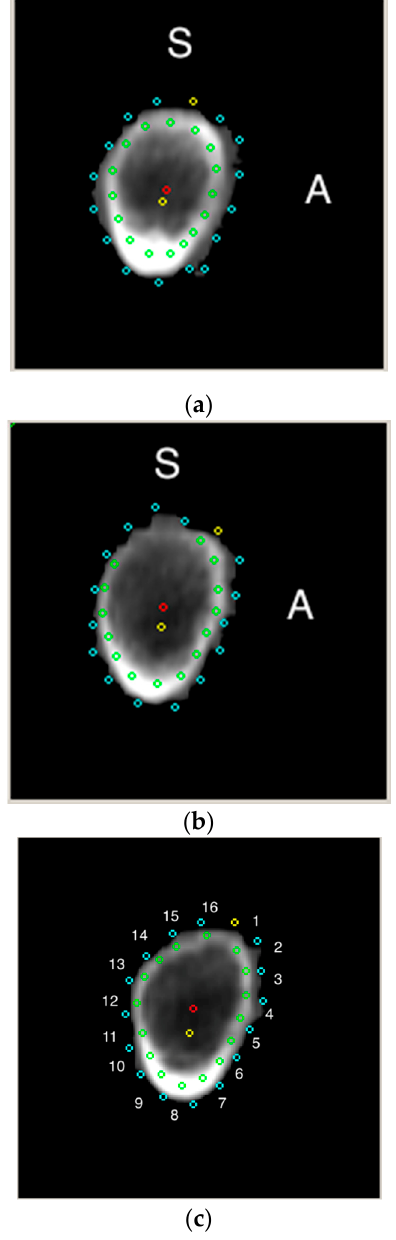
Figure 3. The narrow femoral neck region was found automatically as a perpendicular plane to femoral neck axis where the approximate diameter ratio (superior-inferior and anterior-posterior) was 1.4—producing the lowest cross-sectional area of the femoral neck. Note marked boundaries of 16 sectors (from the most top, clockwise—Figure 3c). Figure 3a - a cross-section of patient with normal BMD, in Figure 3b analogous region in a patient with osteoporosis. Note the diminished cortical thickness in postero-superior region with decreased BMD. S—superior, A—anterior, red dot—geometric center, yellow dot—center of mass.